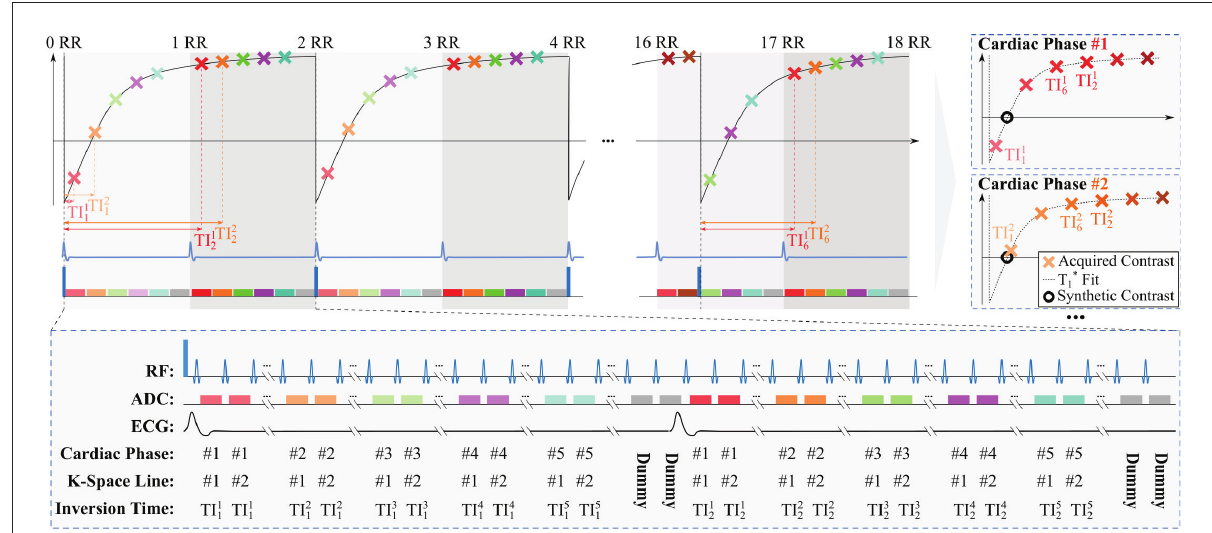
FIGURE1 Sequence diagram of the proposed functional LGE sequence. Prior to the inversion pulses shown, magnetization is driven to pulsed steady-state via repeated FLASH pulses. Subsequently, an adiabatic pulse is performed to invert the magnetization. Then, contiguous FLASH imaging pulses are played to read out the magnetization during its re-recovery to the pulsed-steady state. The acquisition is segmented, thus, multiple inversion pulses are required to fill the k-space for each cardiac phase. In order to ensure a dense sampling of the inversion recovery curve for each cardiac phase, the Look-Locker experiment is then repeated multiple times with varying inversion pulse offset with respect to the R-wave. As the recovery to the pulsed-steady state spans across two RR-intervals, for each cardiac phase i two inversion times TI i j are acquired per inversion pulse offset. Thus, a total of 1 ≤ j ≤ 6 inversion times, are acquired per cardiac phase for three inversion pulse offsets. Due to the limited number of inversion pulse offsets, a different sampling of the inversion recovery curve is realized for each cardiac phase, as indicated in the top right panels. Following the acquisition, a semi-quantitative inversion recovery model is fit on these multiple inversion points per cardiac phase to synthesize LGE contrast with suppression of the healthy myocardial